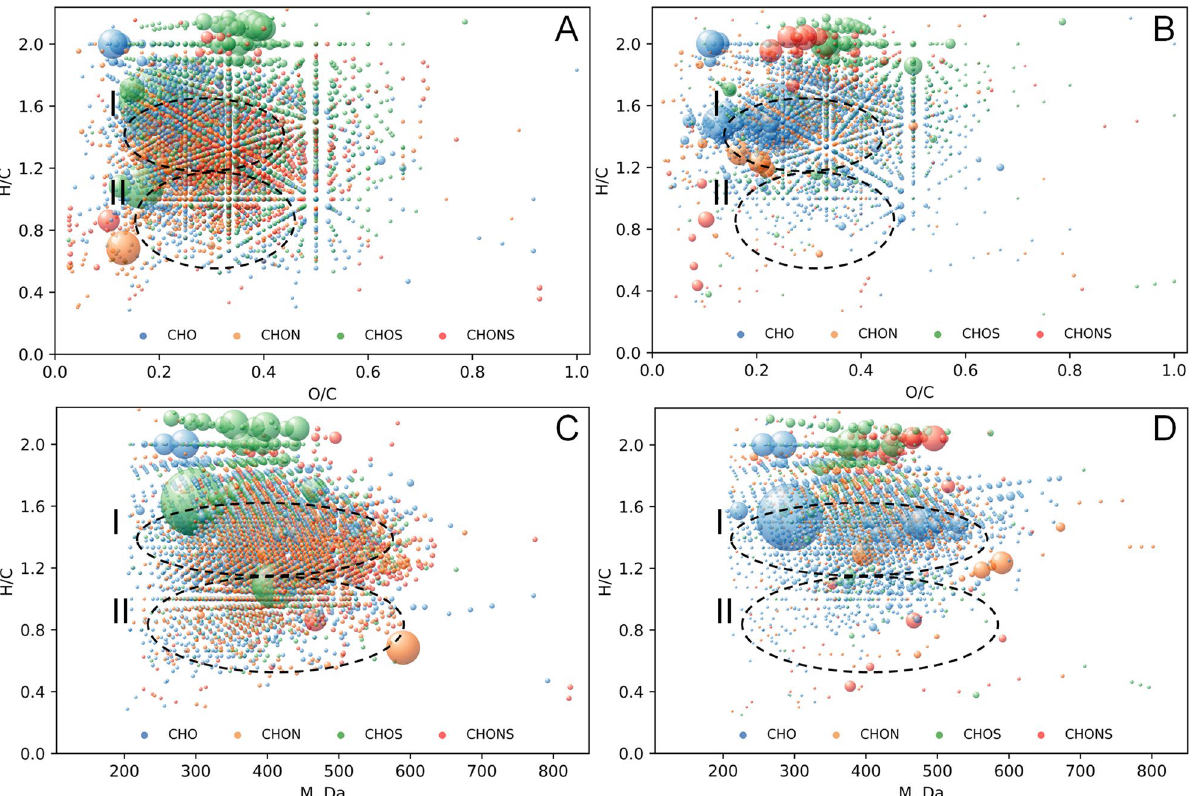
Figure 6. Van Krevelen diagrams ( A , B ) and H/C versus molecular mass diagrams ( C , D ) for molecular compositions identified in the alkali-extracted IOM samples. The dot size represents relative intensity of the corresponding peak in the FTICR mass spectrum. CHO, CHON, CHOS, and CHONS compositions are highlighted in blue, orange, green, and red, respectively. Regions I and II correspond to substituted and condensed aromatic species. Left and right panels correspond to Murchison and Allende extracts,